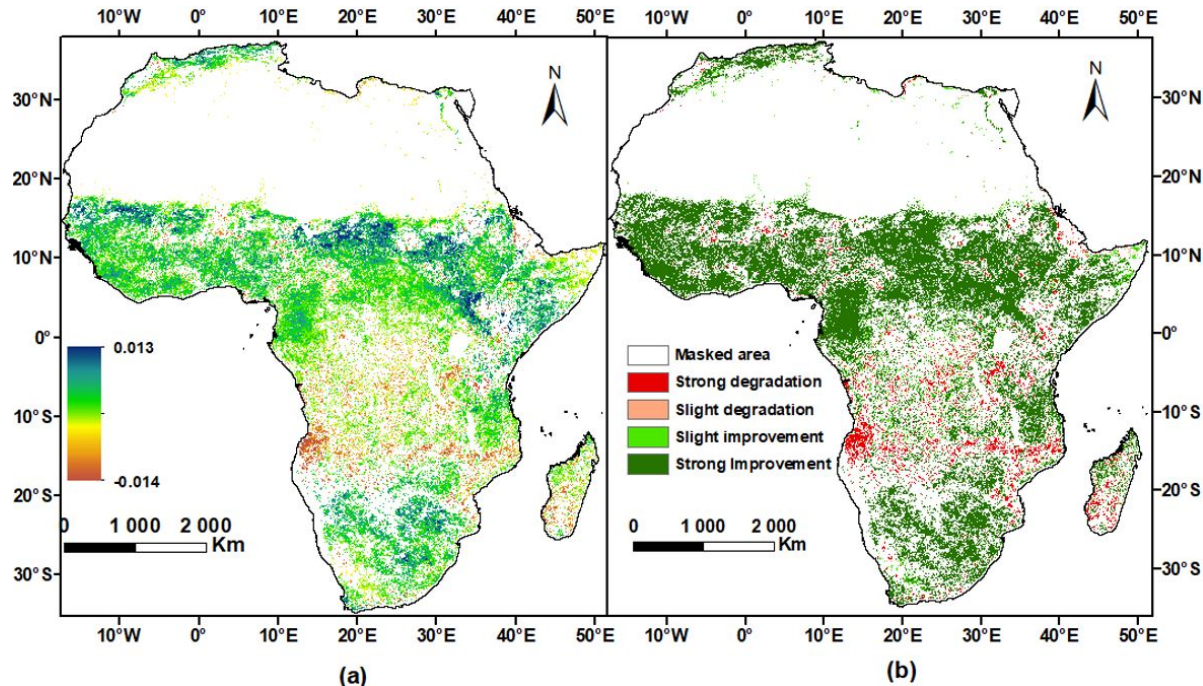
Figure 5. Overall trends of Annual NDVI3g for 34 years of the study (1982 to 2015). ( a ) Shows the overall trends of annual NDVI3g in terms of year; ( b ) shows classified overall trends into four classes: Strong degradation from − 0.014 to − 0.001/year, slight degradation from − 0.001 to 0, slight improvement from 0 to 0.001, strong improvement from 0.001 to 0.013/year. Only significant values (<0.05 of p -Value) are mapped. This figure is adapted based on the original figure from publication